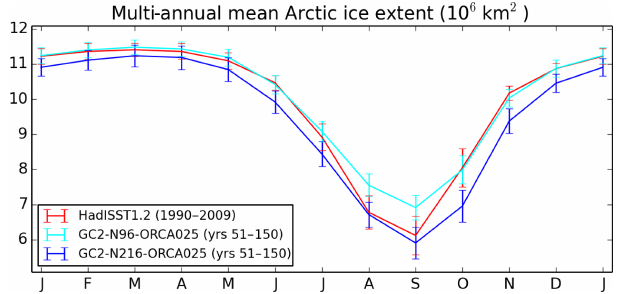
Figure 6. Sea ice extent multi-annual mean seasonal cycles from the HadISST1.2 observational dataset as well as GC2-N96 and GC2- N216 climate model runs. Error bars represent standard deviations on the multi-annual means for each month, calculated over the same years as the means themselves. The ice extents in GC2-N216 and HadISST1.2 are seen generally to be within 1 standard deviation of each other.